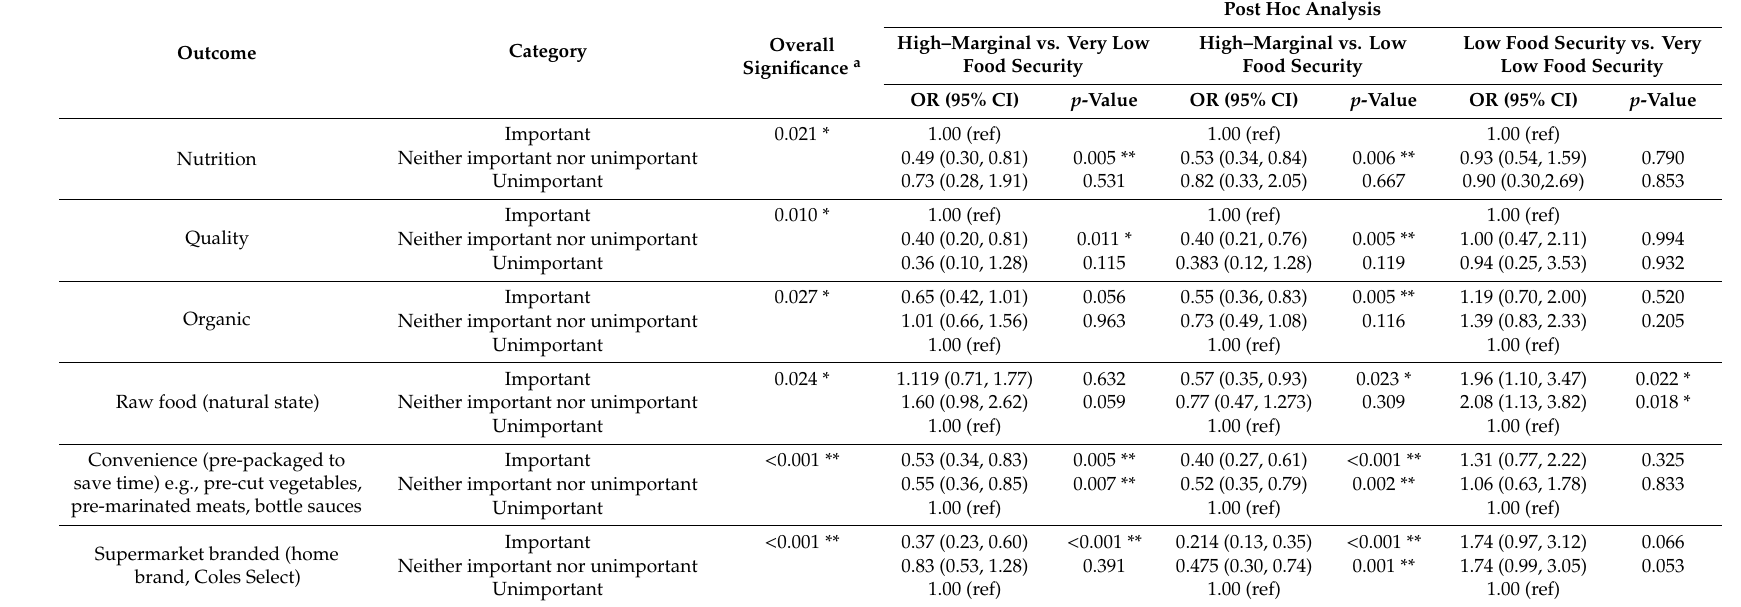
Table 3. Significant food product attributes.